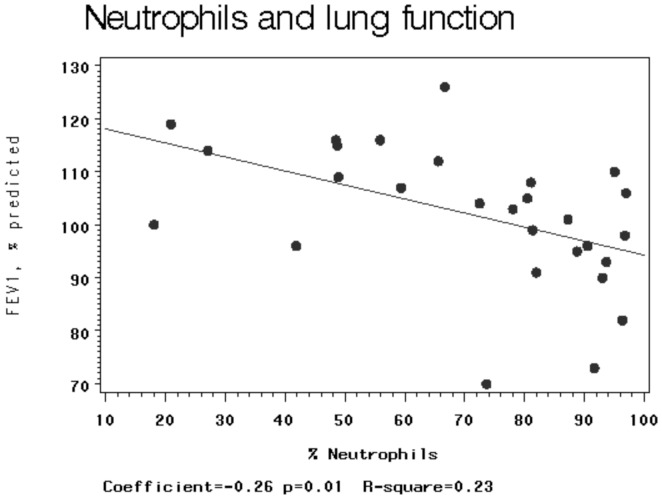
Simple linear regression between percent neutrophils (independent variable) and percent predicted FEV1 (dependent variable).Dots represent individual estimates. Solid line is made to linear best fit model.